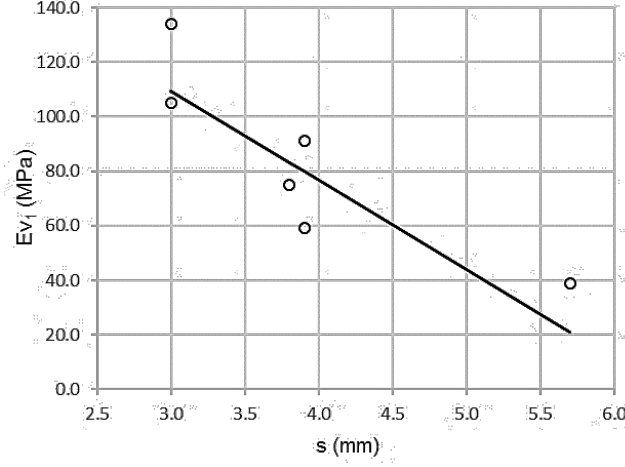
Figure 1. Scatterplot topographic settlement test and first modulus of plate bearing test (PLT) ( ɸ Figure1. Scatterplottopographicsettlementtestandfirstmodulusofplatebearingtest(PLT)( Φ 600mm). 600mm).